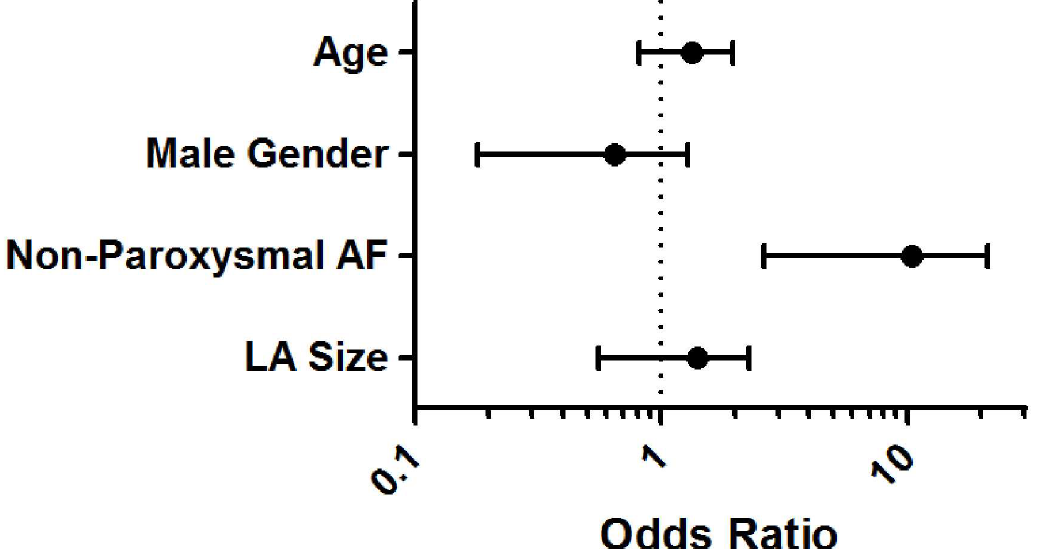
Fig 3. Non-paroxysmalAF (OR 7.47 [95% CI 2.62 to 21.29], P < 0.001)is independently associatedwith non-PV mediated AF when adjusted for age (per decade), gender, and LA size (per cm).